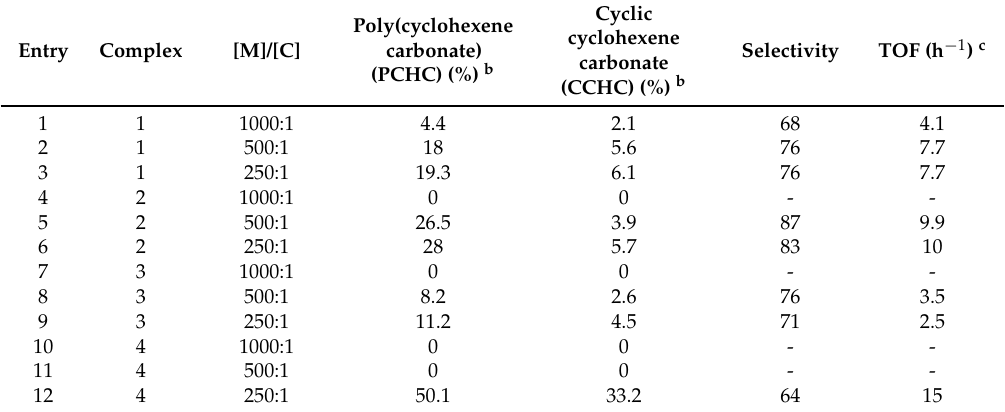
Table 1. Effect of catalyst loading on catalytic activity a